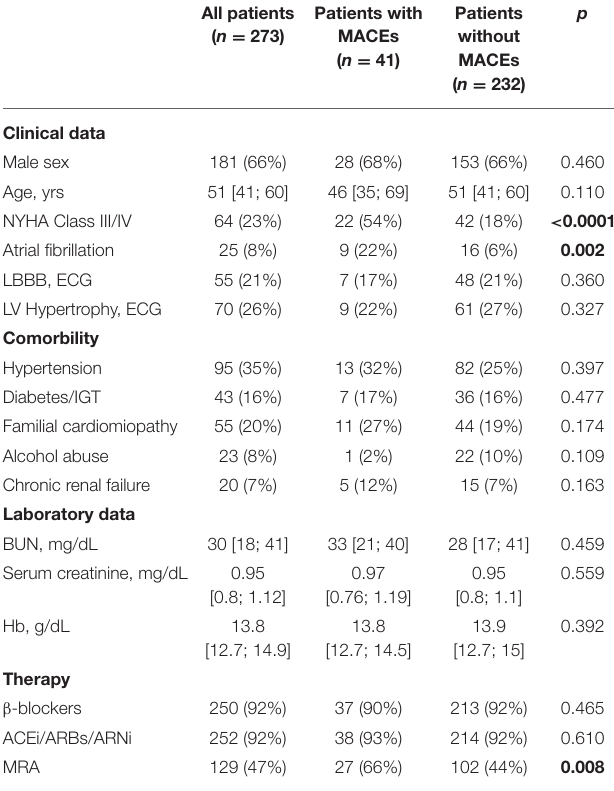
TABLE 1 | Characteristics of the study population according to experience of the primary end-point * . All patients ( n =